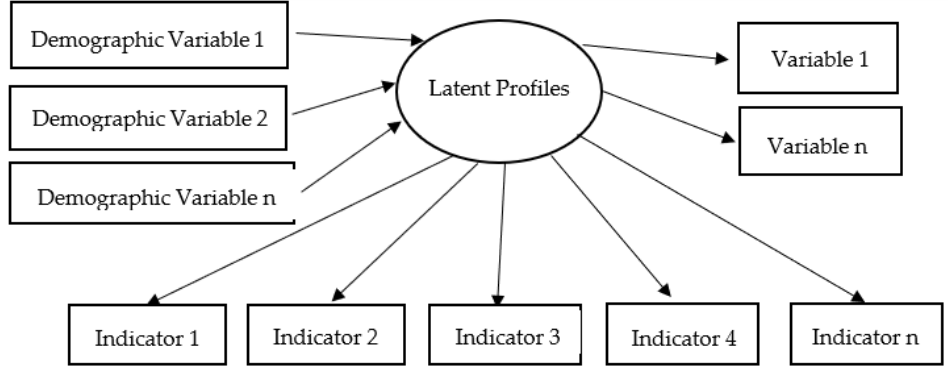
Figure 1. Framework diagram for the purpose of current study.